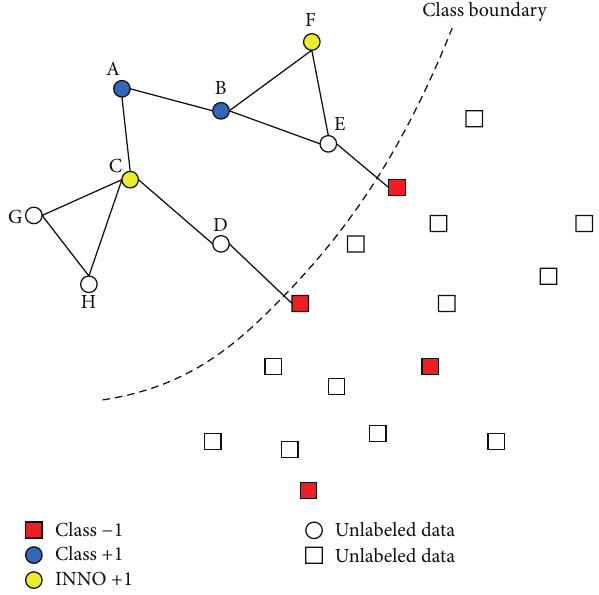
Figure 3: INNO algorithm